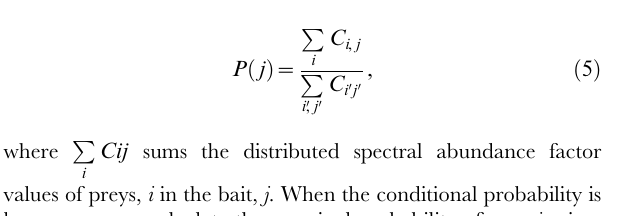
Figure S1 General strategy for assembling intensity based local protein interaction network. Eleven unique bait proteins were TAP tagged and their respective protein interactions